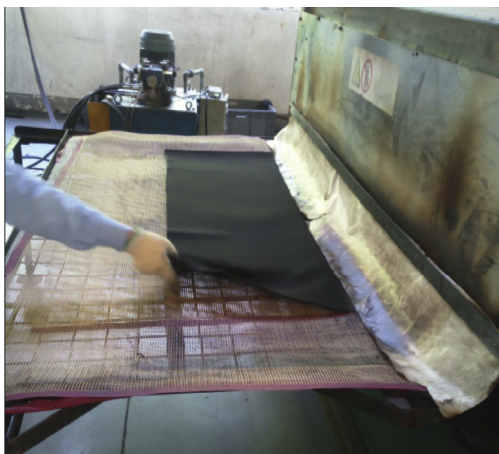
Figure 8: Heating raw material.